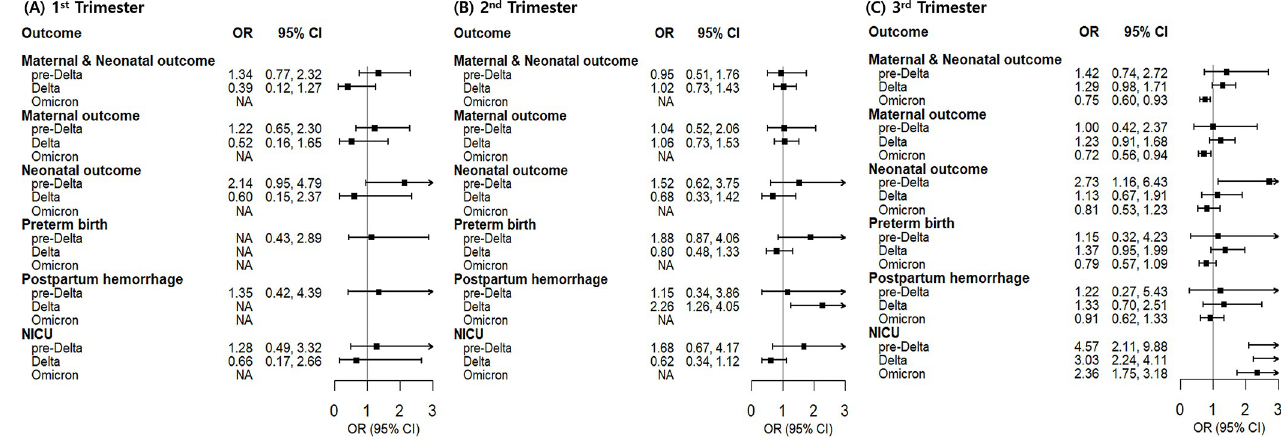
Fig 3. Association of COVID-19 infection in trimester of pregnancy with maternal and neonatal adverse outcomes using 1:4 propensity score matching. The arrow indicates when the 95% confidence intervals boundary is beyond the axis limit. NA denotes model not applicable. Abbreviations: CI, confidence intervals; OR, odds ratio; NICU: neonatal intensive care